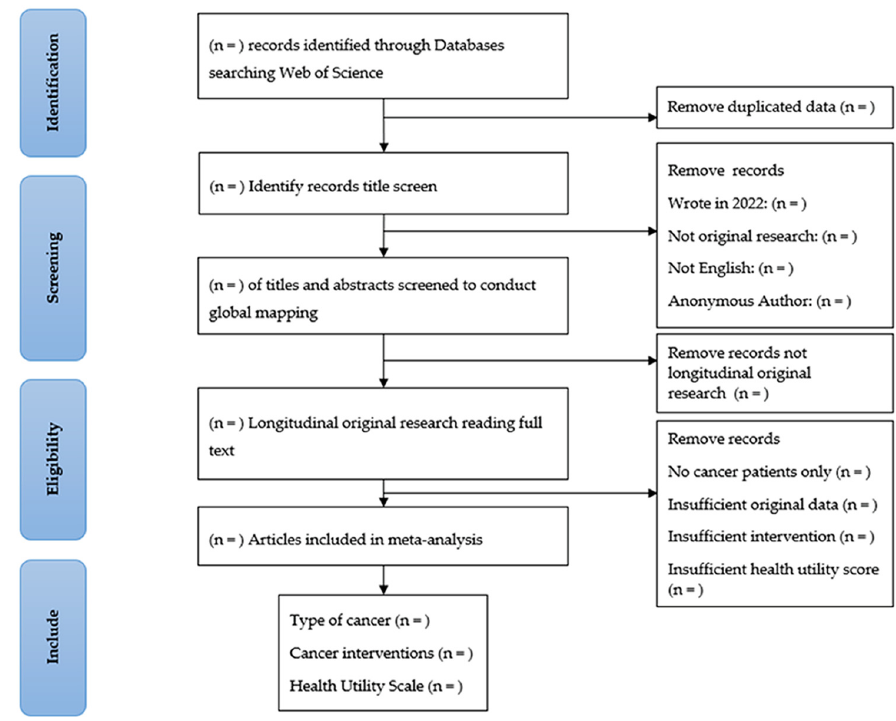
Figure A1. Diagrammatic presentation of the study’s selection process for systematic review. Table A1. Draft of search strategy to be used in online databases. Terms Keywords Results